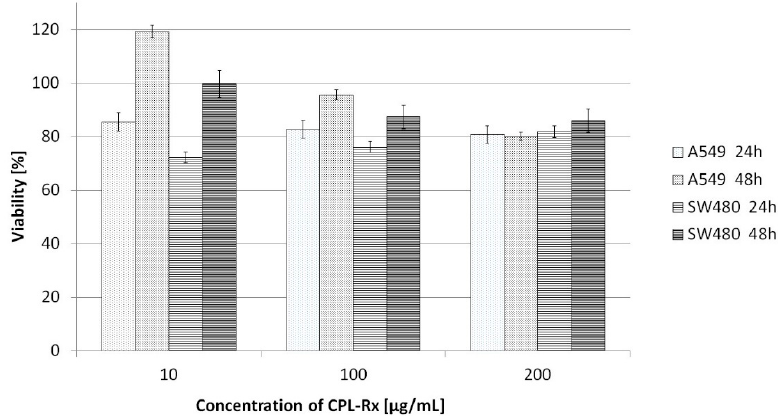
Figure 3. Antiproliferative activity of CPL-Rx expressed as % of viability.